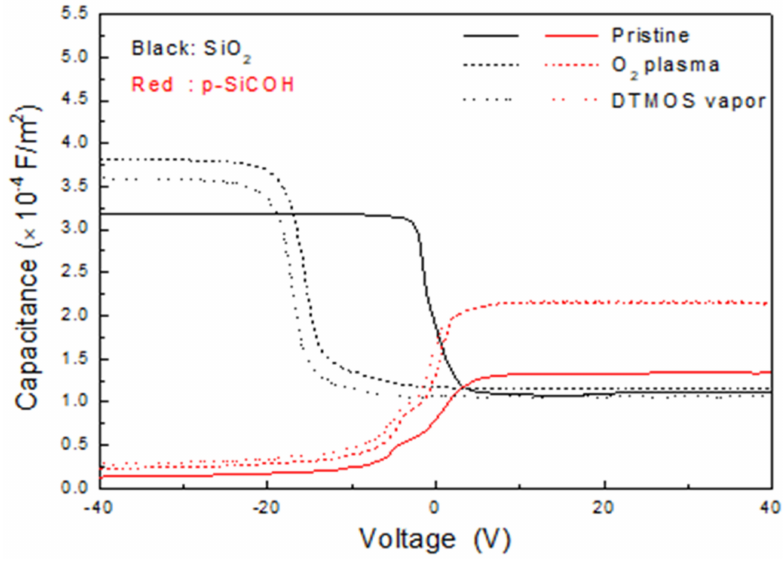
Figure 4. C-V curves of pristine and DTMOS vapor-treated SiO 2 and p-SiOCH films.